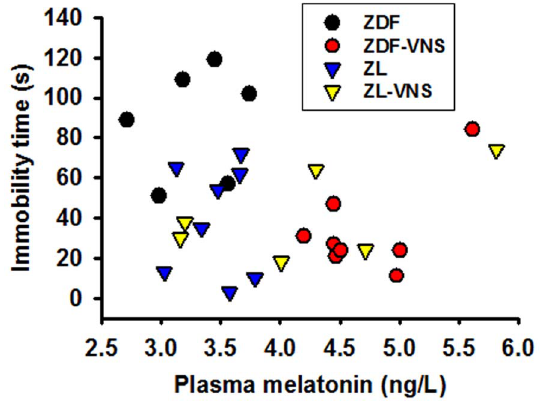
Figure 4. Correlation of melatonin concentration and immo- bility time in FST on day 35. Linear regression analysis found a strong negative correlation between the plasma melatonin concentra- tion and the immobility time in forced swimming test in ZDF (R= 2 0.544) but not ZL rats (R=0.254, also see Table 3).